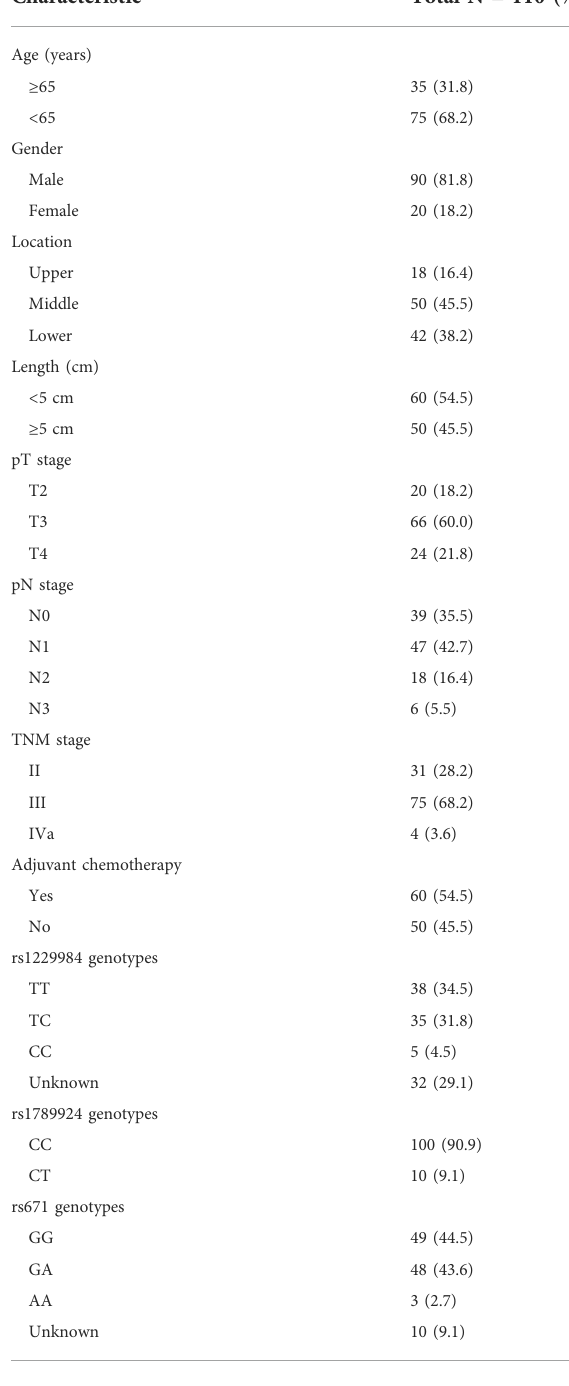
TABLE 1 Clinical features and genotypes of all the patients.